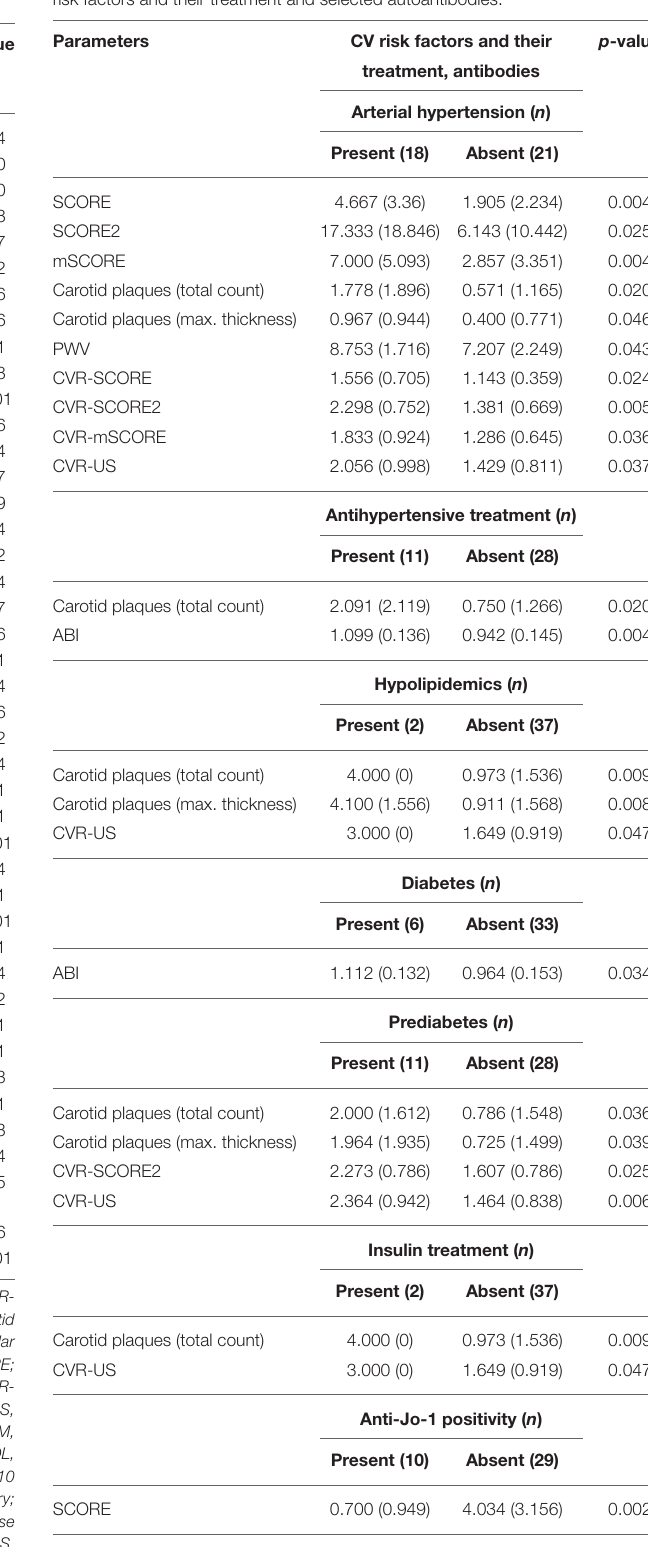
TABLE 8 | Association of cardiovascular risk factors and subclinical atherosclerosis markers with disease-specific features, body composition parameters, and traditional risk factors in IIM, based on bivariate correlations.